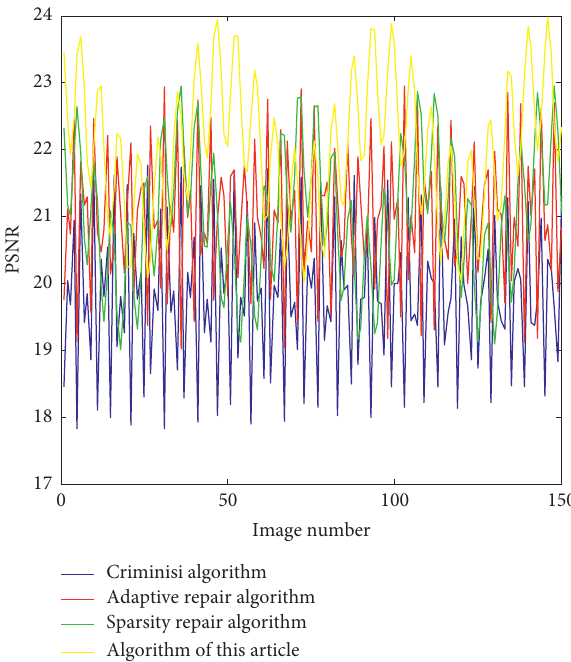
Figure 16: PSNR comparison of various algorithms.